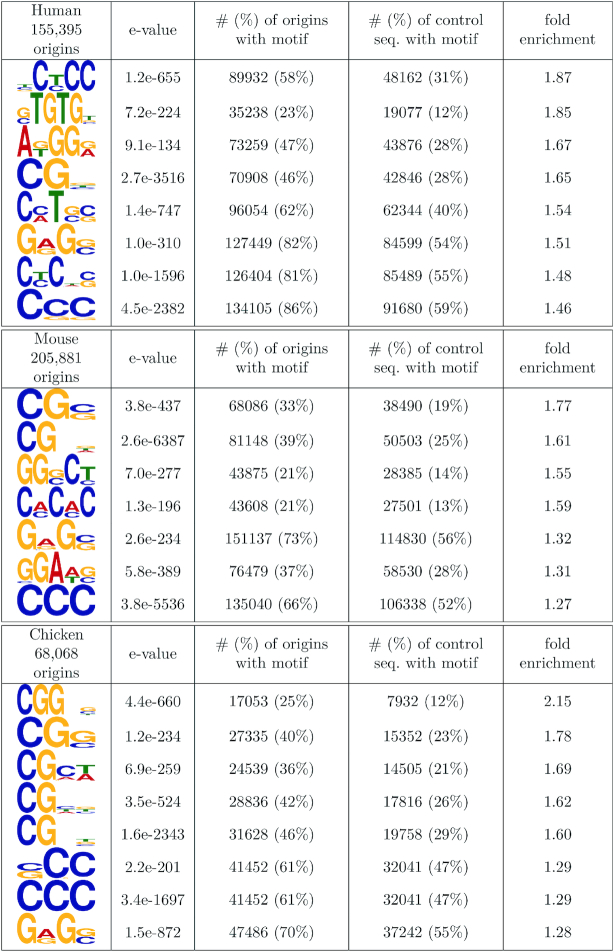
Motifs enriched in the 40 bp core region of origins for each species. Motifs were detected by adjusting the background model to compositional heterogeneities (see Materials and Methods). Control sequences were obtained by randomly sampling the same number of 40 bp regions in each genome.